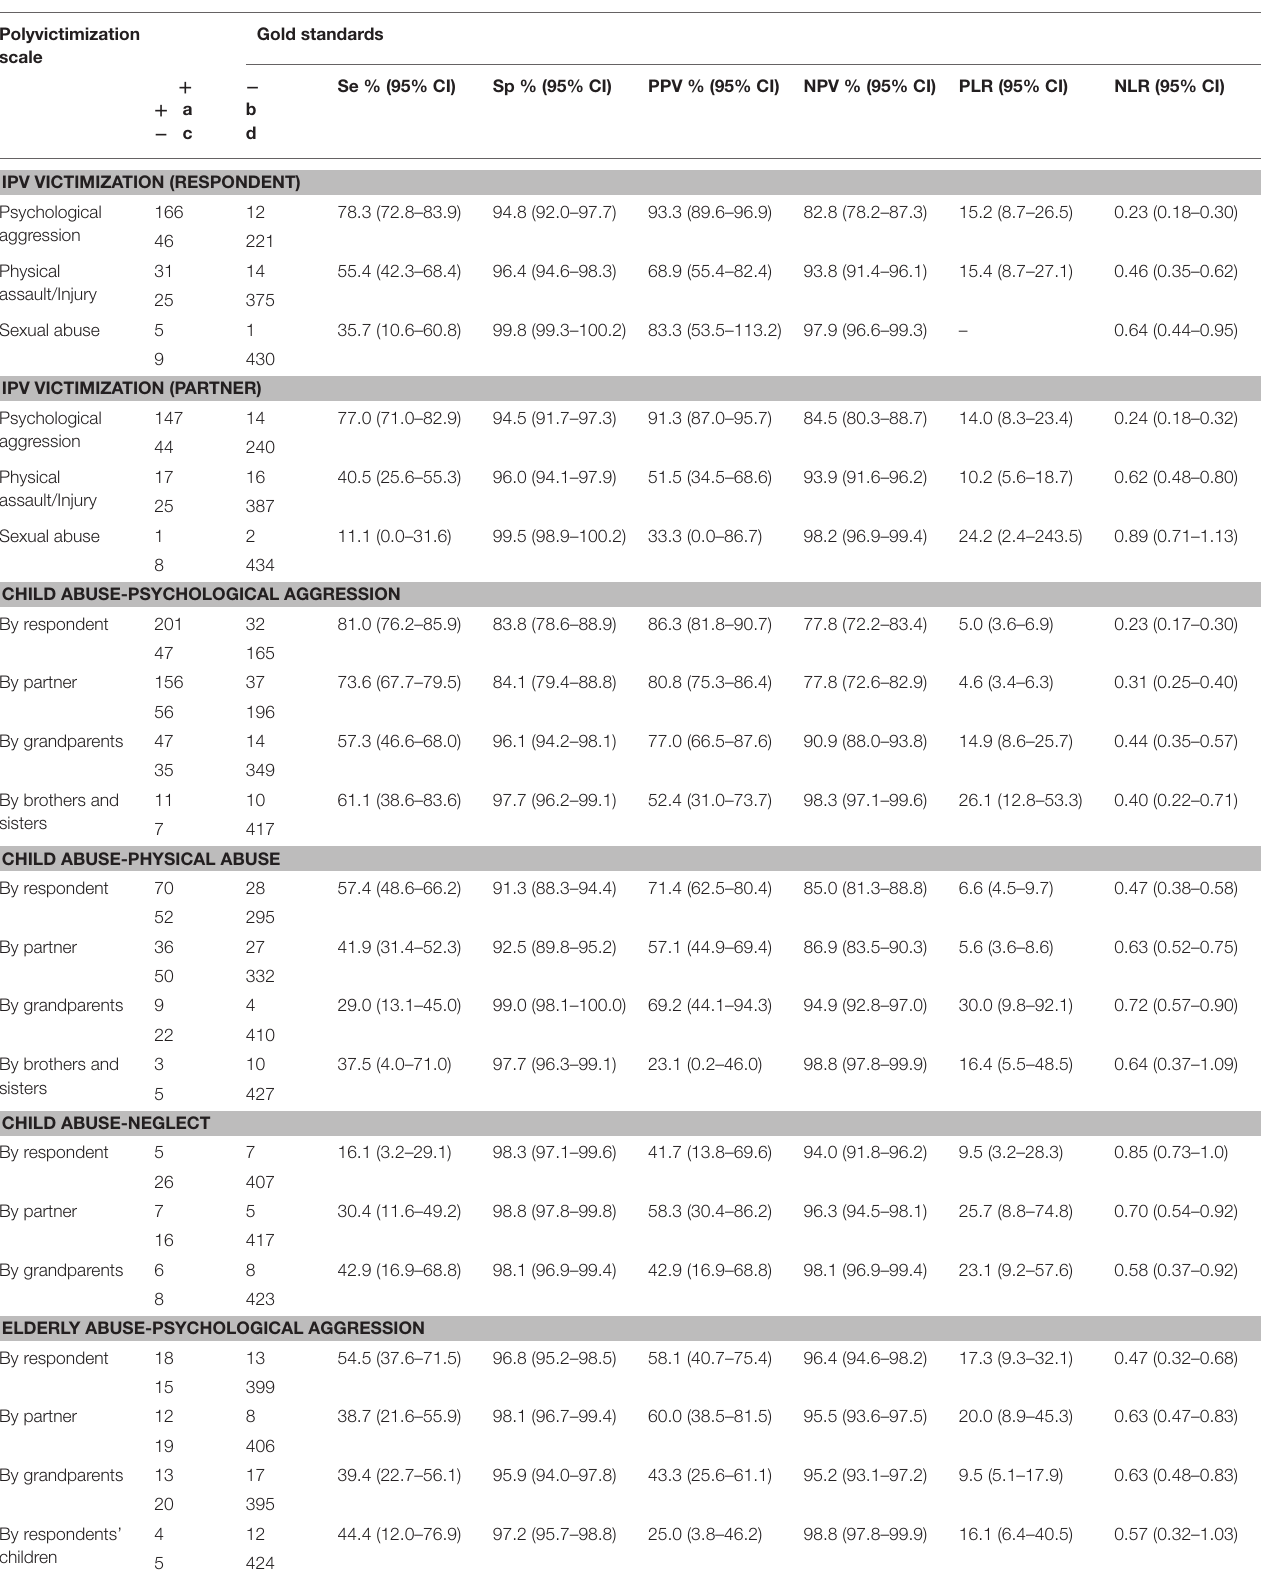
TABLE 2 | Accuracy of the family polyvictimization scale for screening preceding-year family victimization ( N = 445). Polyvictimization Gold scale